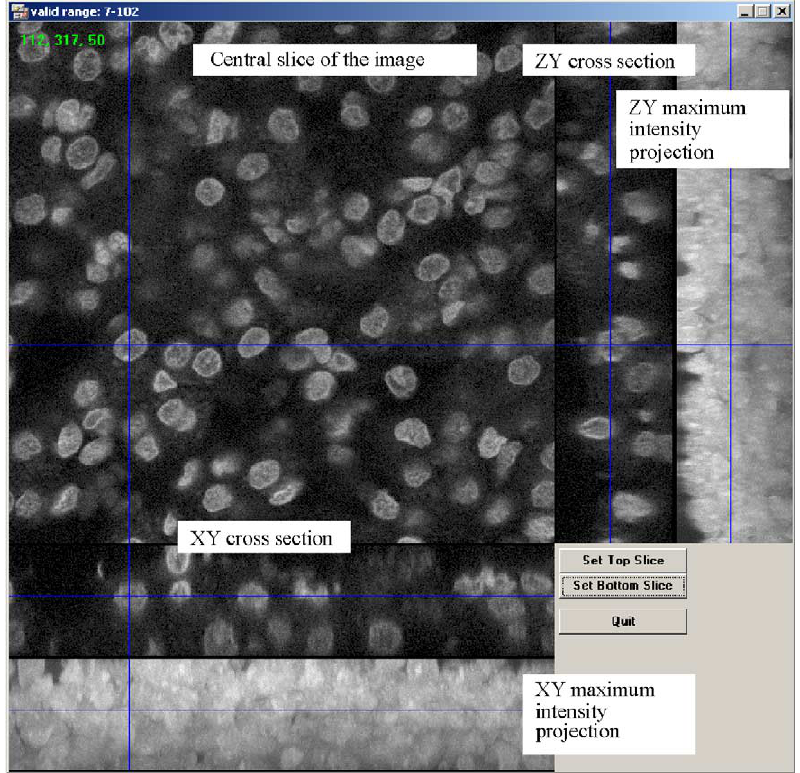
Fig. 1. ZX and YZ projections and cross sections obtained with 3D DNA confocal laser scanning based image cytometry of adrenal tissue, allowing to identify and remove nuclei that have been cut-off at the top or the bottom of the 14 µ m thick section. The crosshair defines the planes that are being shown at the right and the bottom sides, while the maximum intensity projections are obtained from the entire image stack and do not change with the position of the